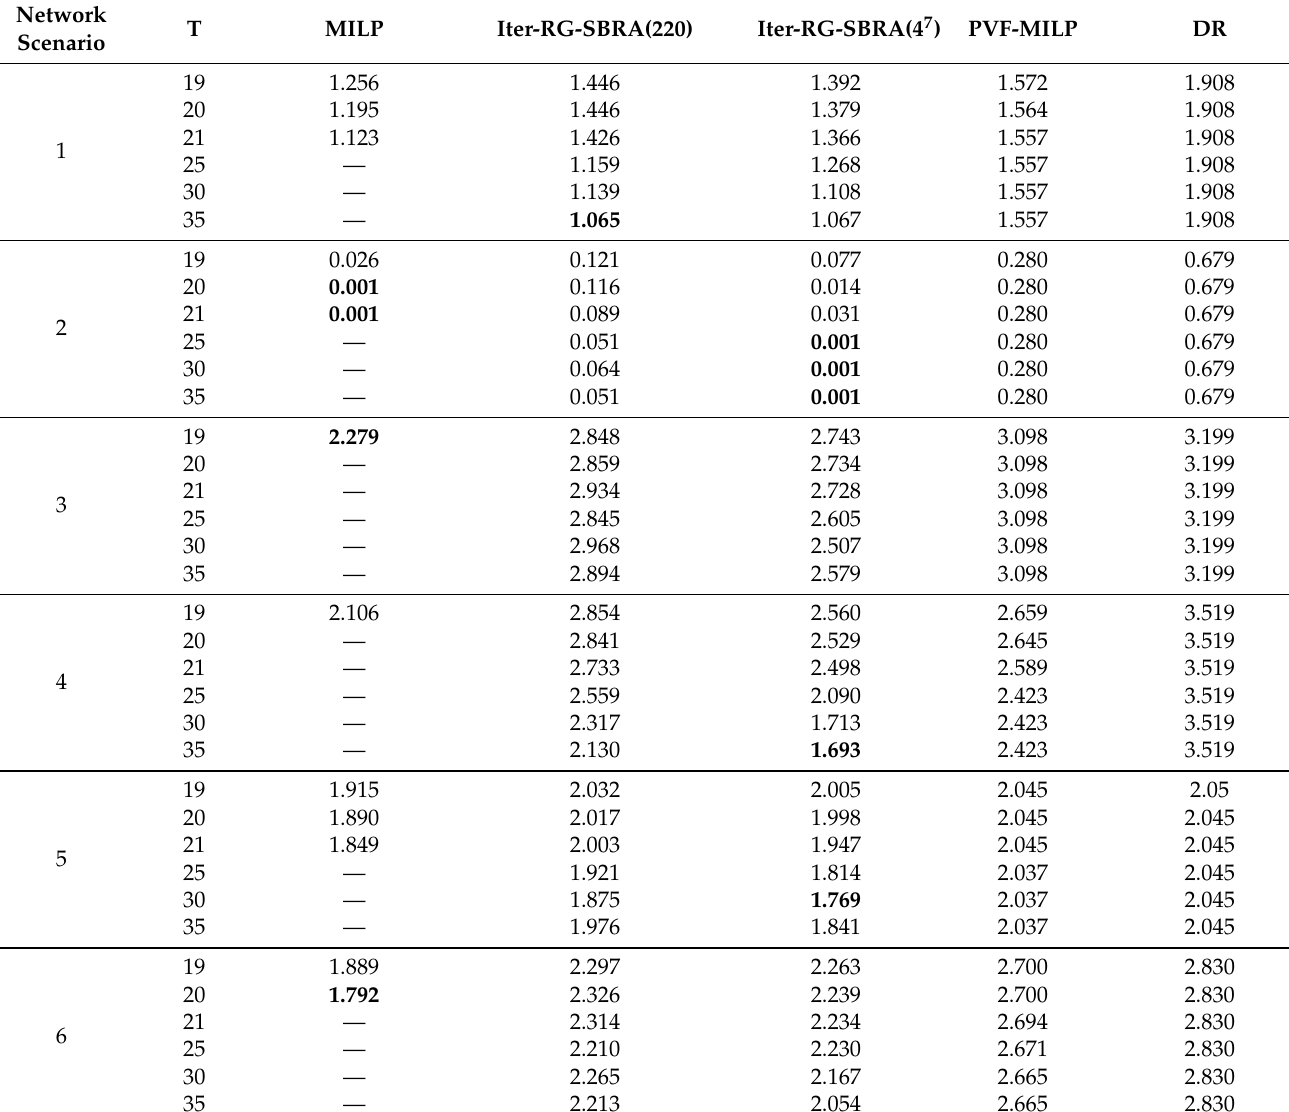
Table 5. The total packet loss (in GB) for all tested algorithm configurations and network scenarios.